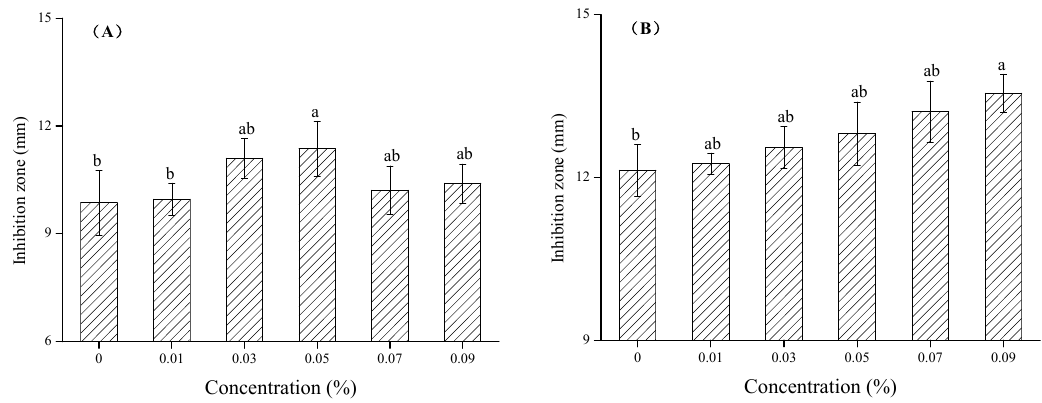
Figure 8. Values of inhibition for E.coli ( A ) and S.aureus ( B ) after the treatment by the chitosan-based coating film with TiO 2 nanoparticles. Note: mean bars with di ff erent letters (a, b and ab) in the same microorganism at di ff erent concentrations of TiO 2 nanoparticles indicate significant di ff erences at p < 0.05.